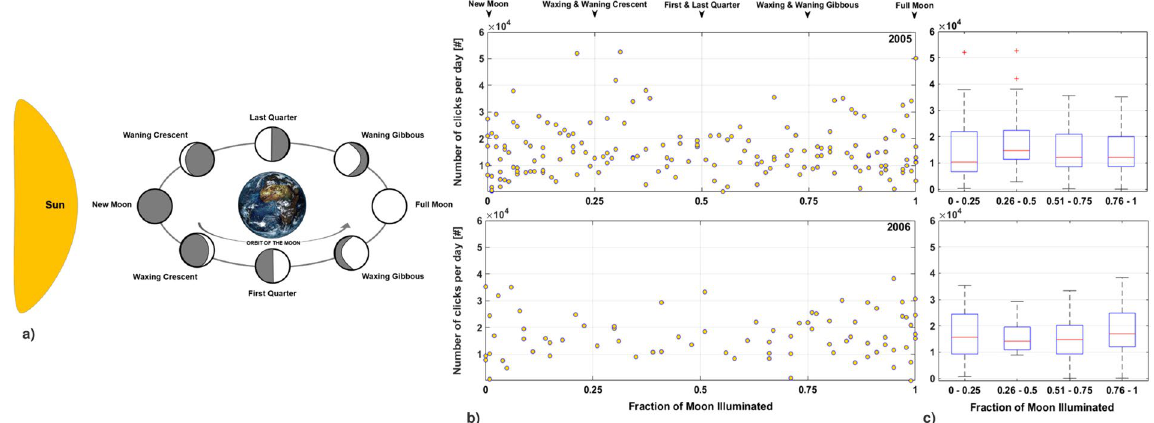
Figure 7. Influence of the Lunar Cycle. ( a ) Variation of the fraction of moonlight in relation to different lunar phases. ( b ) Scatterplot shows the number of clicks recorded per day (5 min/h) in relation to the increase of the fraction of Moon illuminated (top: 2005; bottom: 2006). ( c ) Number of clicks recorded per day with the dataset divided into four categories of moon illumination. On each box, the central mark indicates the median, and bottom and top edges of the box indicate 25 th and 75 th percentiles, respectively. Whiskers extend to the most extreme data points not considered outliers, and outliers are plotted individually using the ‘ + ’ symbol (in red).